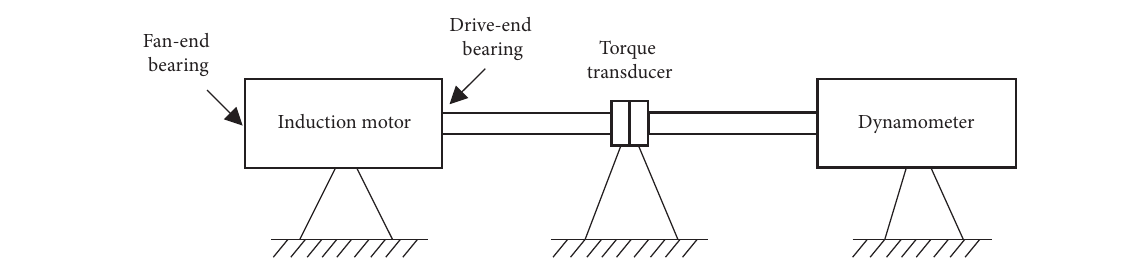
Figure 3: The rolling element bearing experimental bench. Table 1: Fault information of bearings with different fault locations and defect